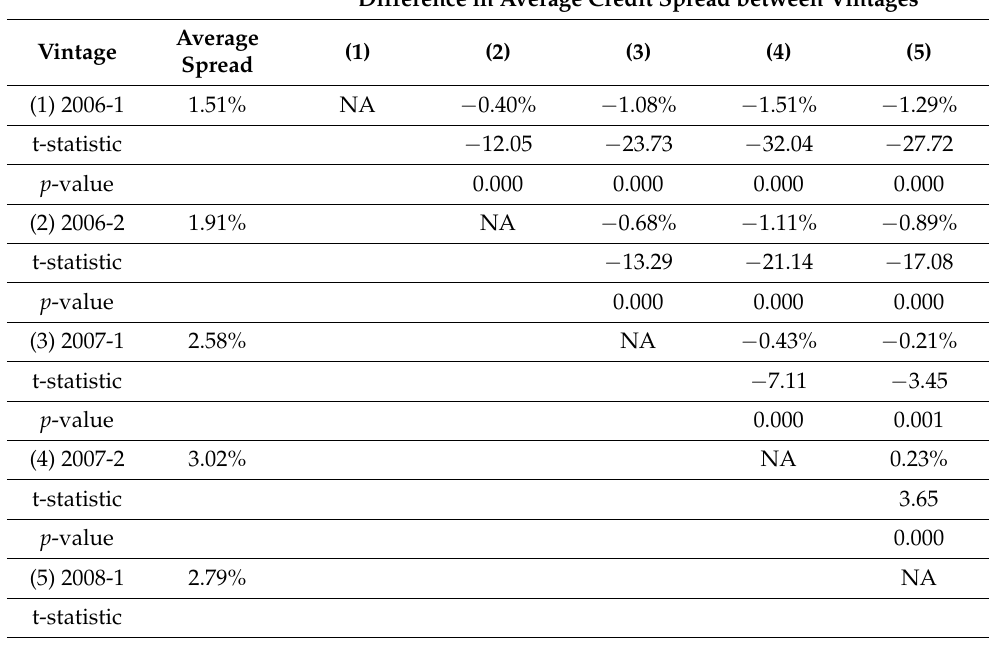
Table 2. t -tests of the differences in average credit spreads among the five different vintages of the CMBX index from 24 July 2009, to 30 September